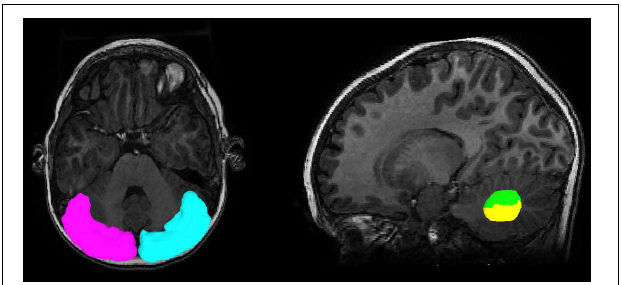
FIGURE 1 | Regions of interest to track streamlines containing PC efferent axons. The posterior-lateral cortex of the cerebellum (seed region, magenta for left, cyan for right) and two subdivisions of the dentate nucleus (target region, green for DDN, yellow for VDN) were objectively placed for the tractography using the SUIT normalization